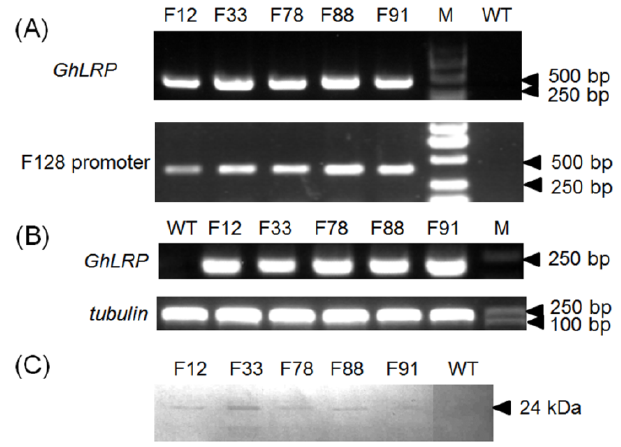
transgenic events. ( A ) PCR analysis of five Figure 2. Molecular analyses of several T 1 transgenic lines. PCR was performed using primers corresponding to the GhLRP sequence (top) and the promoter F128 sequence (bottom). M, DNA marker; WT (wild-type): the were used as a negative control; segregating populations of hybrid 08 × 178 in T 1 ( B ) Reverse transcription (RT)-PCR analysis. The maize tubulin gene (accession number AY103544) was used as the internal control; ( C ) Western blot